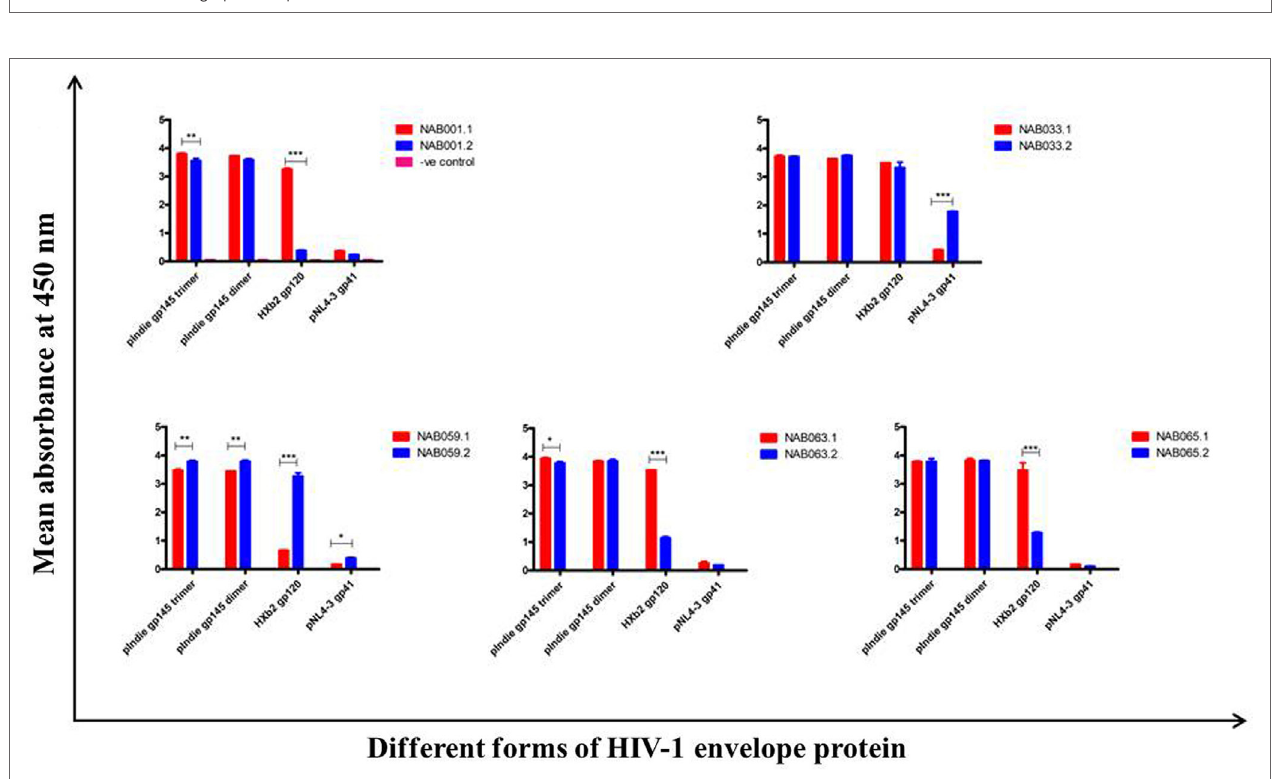
FigUre 4 | ELISA with recombinant HIV-1 envelope proteins. ELISA was performed with 93IN101 gp145 trimer, dimer, HXB2 gp120 monomer, and NL4-3 gp41 monomer proteins. All the BCN plasma samples were tested at 1:200 dilution, and HHP was used as the negative control. Each experiment was performed in triplicate on two independent occasions. * indicates p < 0.05, ** indicates p < 0.01, *** indicates p <